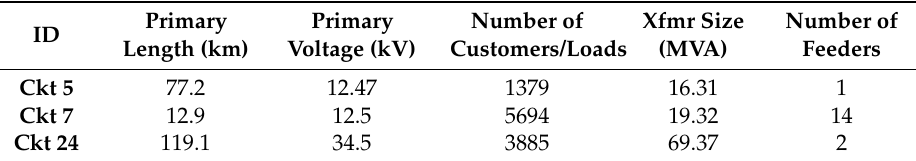
Table 4. EPRI Test Feeders